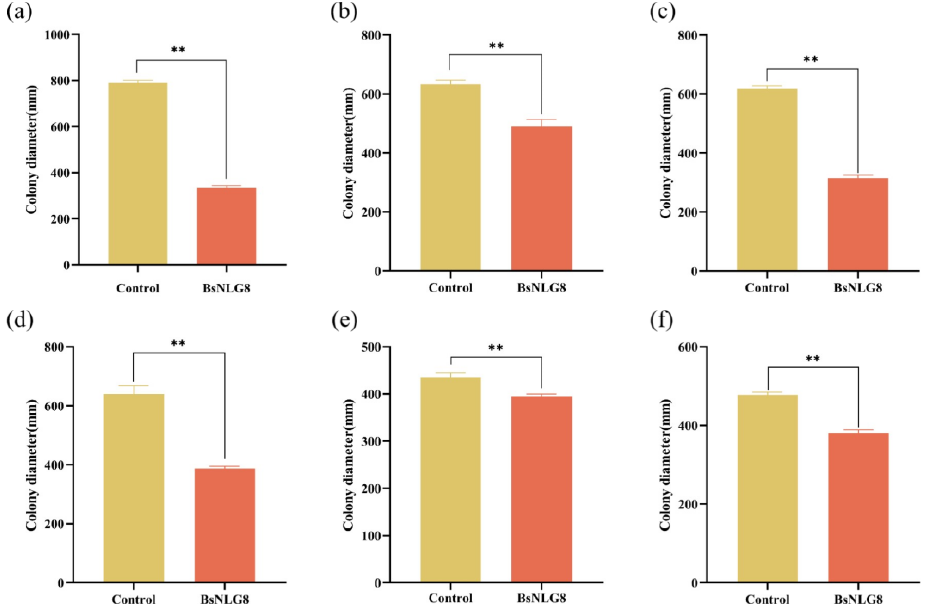
Figure 4. Statistical analysis of the diameter of fungal colonies co-cultured with volatile compounds of bacterial BsNLG8 and 6 kinds of pathogenic fungi. ( a ) F . oxysporum , ( b ) S . curtisii , ( c ) B . Dothidea, ( d ) C . higginsianum , ( e ) G . Candidum, ( f ) M . oryzae . “**” showed significant differences at p < 0.01.